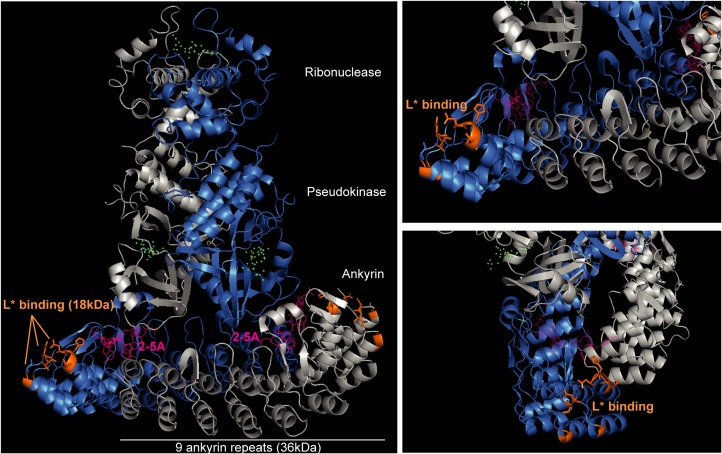
L* footprint on RNase L.Highlighting of residues that were mapped in ANK R1 and R2 as components of the L* footprint on RNase L (in orange). The two RNase L protomers are represented in gray and blue, 2-5A molecules are represented in pink and RNA substrate and ATP mimetics are represented by green dots. (Crystal structure of dimeric human RNase L; [45]; PDB 4OAV). Images were generated using the PyMOL Molecular Graphics System, Version 1.7, Schrödinger, LLC.